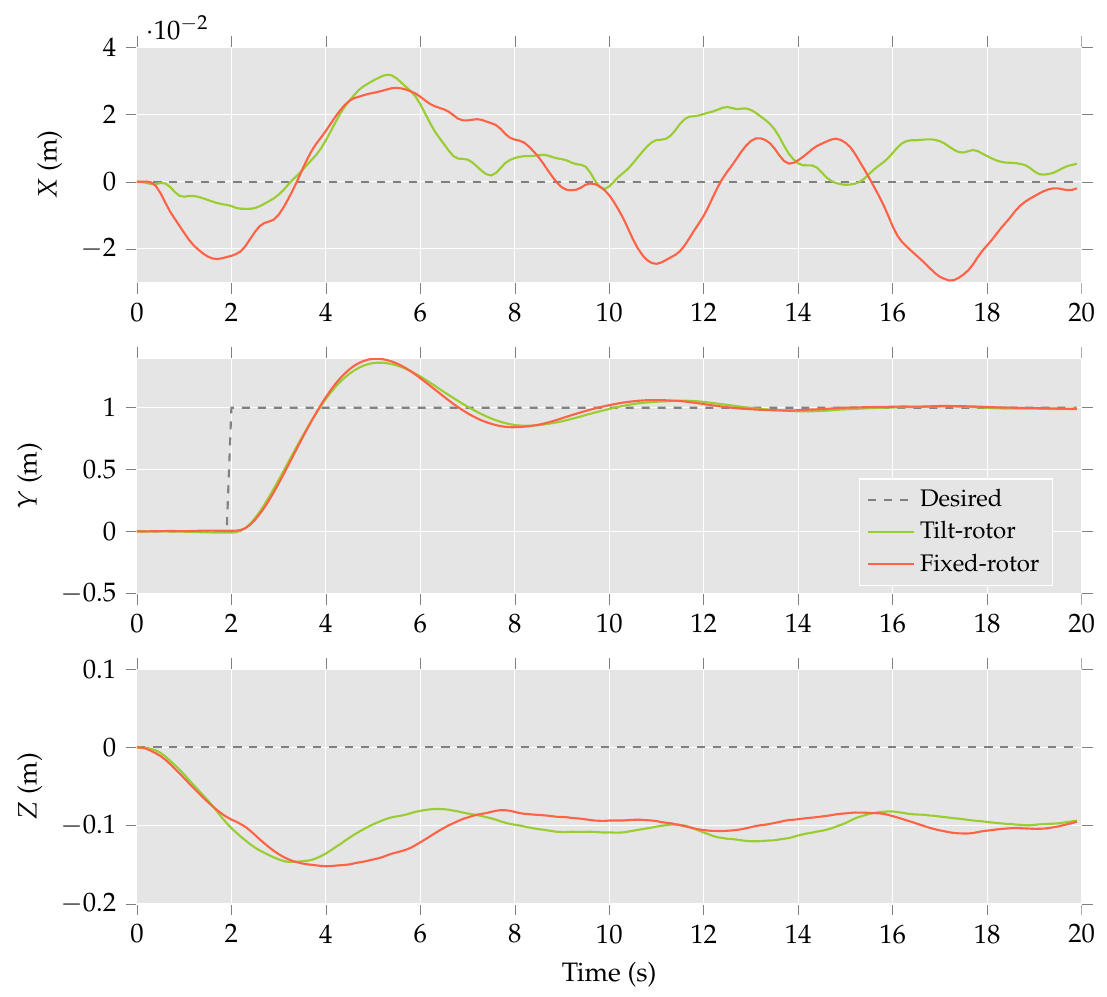
Figure 11. Multirotor helicopter position throughout the second maneuver.